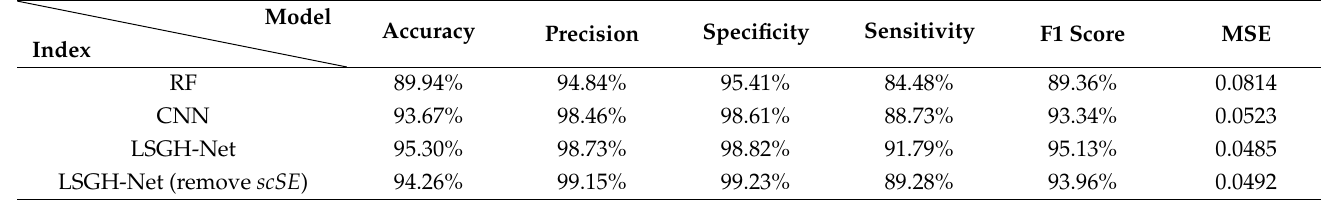
Table 4. Multi-model metrics